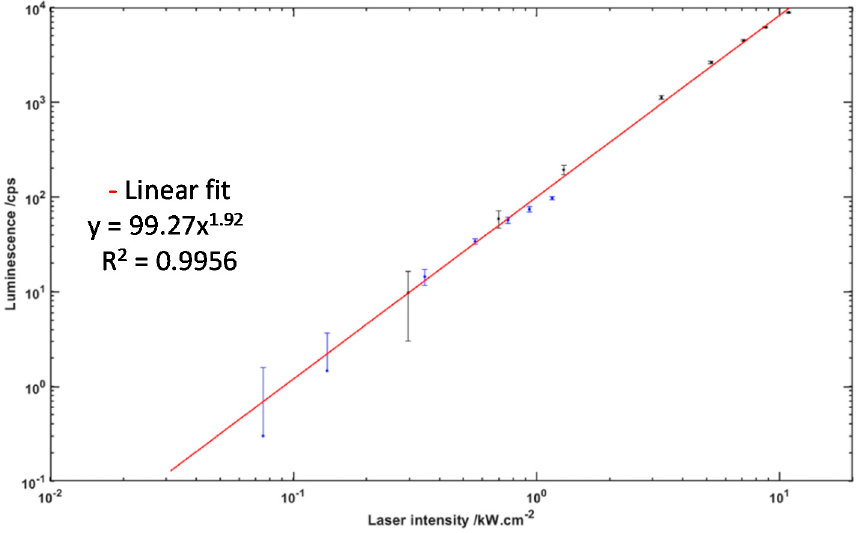
Figure 4. Log–log plot of the Tb-emitted intensity of the 5 D 4 → 7 F 5 transition at 545 nm as a function of the excitation intensity of the 980 nm laser for a 5.3 × 10 -5 M solution of YbL in D 2 O containing a 1.4 equivalent of TbCl 3 ·6H 2 O.